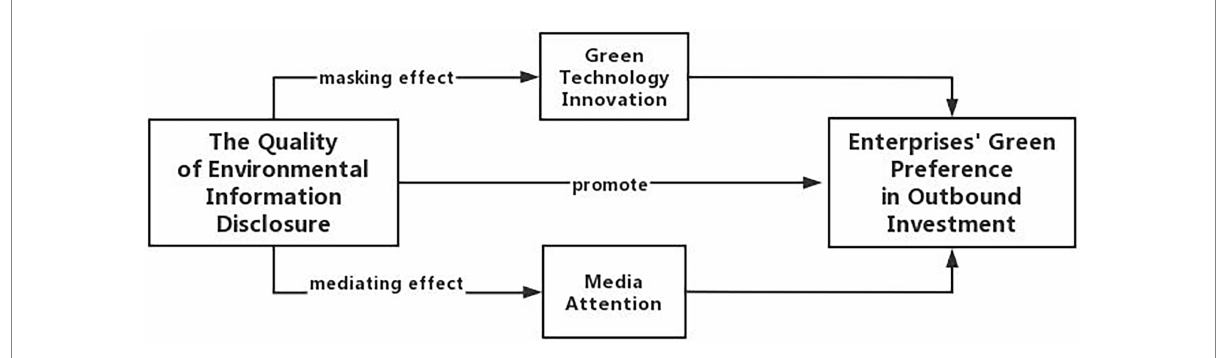
FIGURE 1 Theoretical analysis model